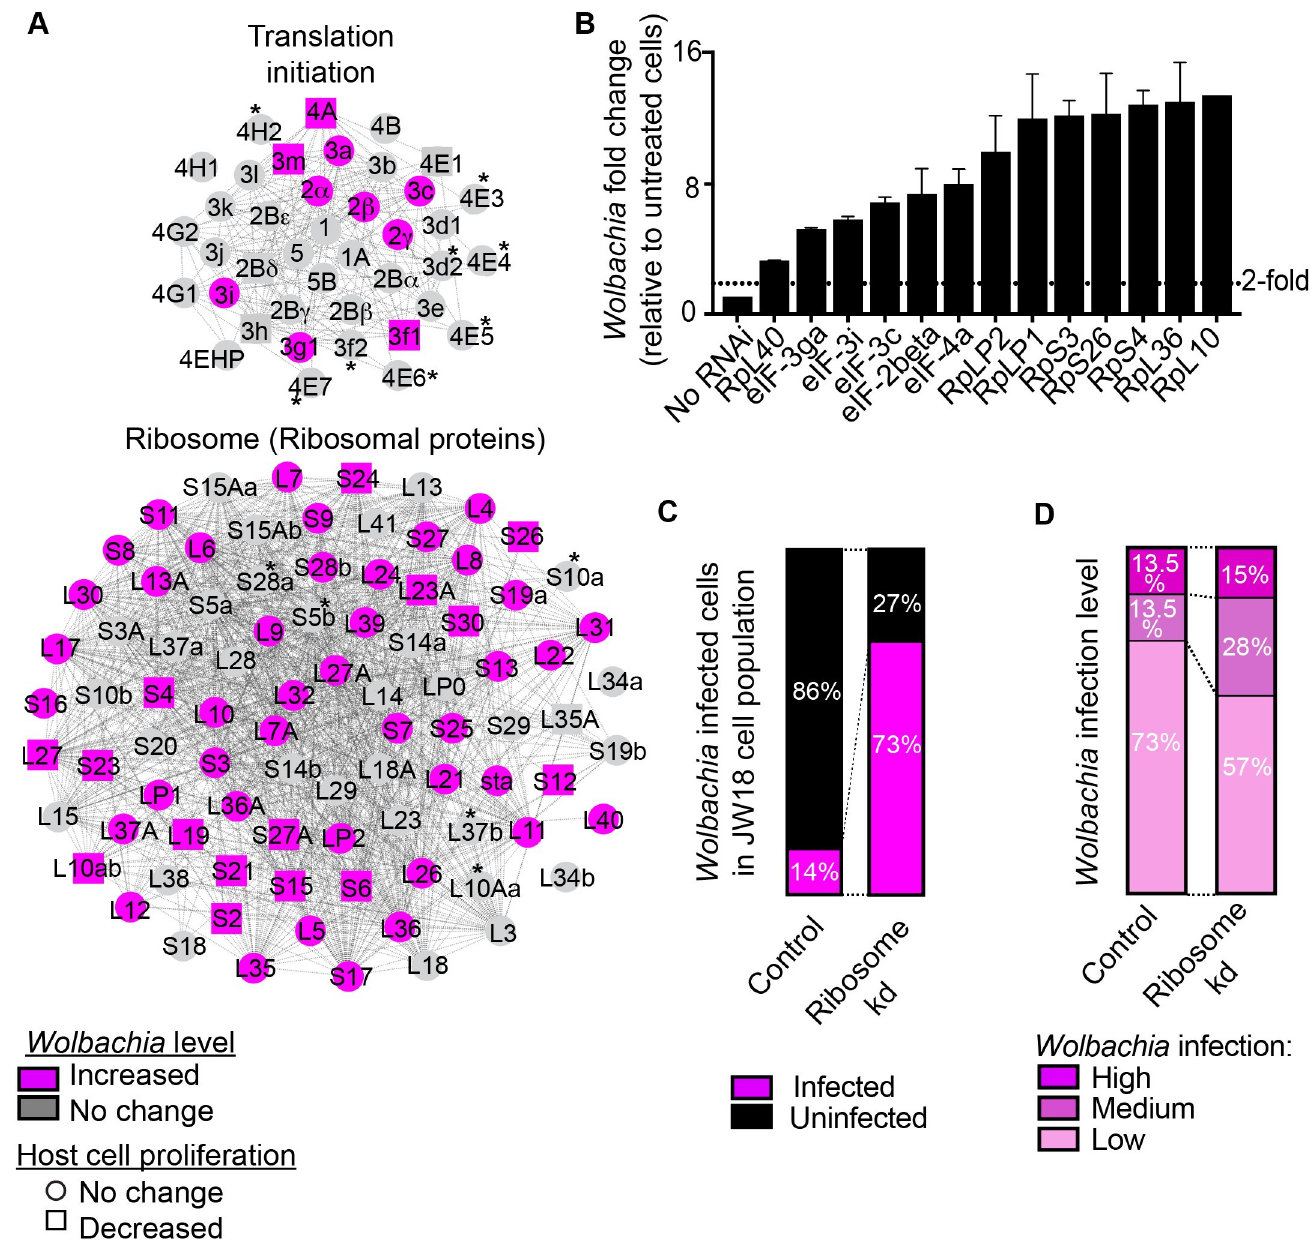
Fig 5. Host translation initiation and ribosome networks suppress Wolbachia levels. (A) The host translation initiation and ribosome networks identified by COMPLEAT and KEGG analysis are enriched for genes that increase Wolbachia levels when knocked down by RNAi in the primary screen. Wolbachia level changes are indicated by color: increases (magenta) and no effect (grey). Asterisks mark network components that are not expressed in the JW18 cell line. Changes in cell proliferation in the whole genome screen assay are indicated by icon shape: no change (circle) or decrease (square). ( B) Representative genes from each network were validated by RNAi. Effects on Wolbachia levels were assessed quantitatively by a DNA qPCR assay measuring the number of Wolbachia genomes (wspB copy number) relative to Drosophila nuclei (RpL11 copy number). Network validation is represented relative to untreated JW18 cells. Note that even in those cases where knockdown of a host gene results in slowed cell proliferation the resulting increase in Wolbachia cell proliferation exceeds that expected. In control culturing conditions, JW18 cells maintain a stable Wolbachia infection level within the population when cells are split 1:1 every 4 days implying that the cells as well as the Wolbachia double in this timeframe. Thus, we would expect that if knockdown of a host gene results in slowed cell proliferation then the resulting increase in Wolbachia would be a two-fold increase at most. Instead, our results show far greater increases in Wolbachia levels. As such, we suggest that the Wolbachia level increases observed cannot be explained by slowed host cell proliferation rate. ( C) Quantification of Wolbachia -infected (magenta) and uninfected (black) cells within the JW18 cell population in control and ribosome ( RpS3 ) RNAi knockdown conditions. Wolbachia infection was detected using the Wolbachia -detecting 23s rRNA FISH probe and cells were identified by DAPI staining of host nuclei. ( D) Classification of the level of Wolbachia infection within infected cells of the JW18 cell population under control and ribosome ( RpS3 ) knockdown conditions (seen in C ). For each cell population > 500 cells were quantified for Wolbachia infection